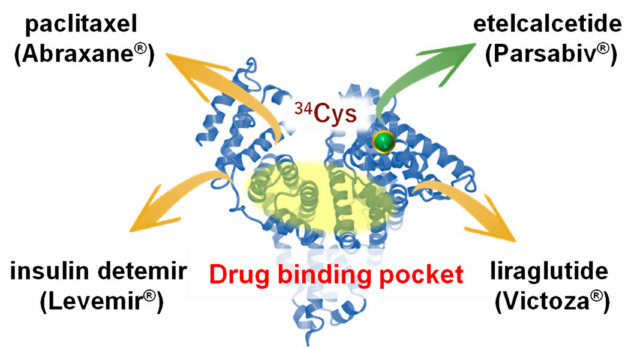
Figure 1. Structural features of albumin and examples of currently marketed albumin-associated pharmaceutical preparations taking advantage of albumin’s innate